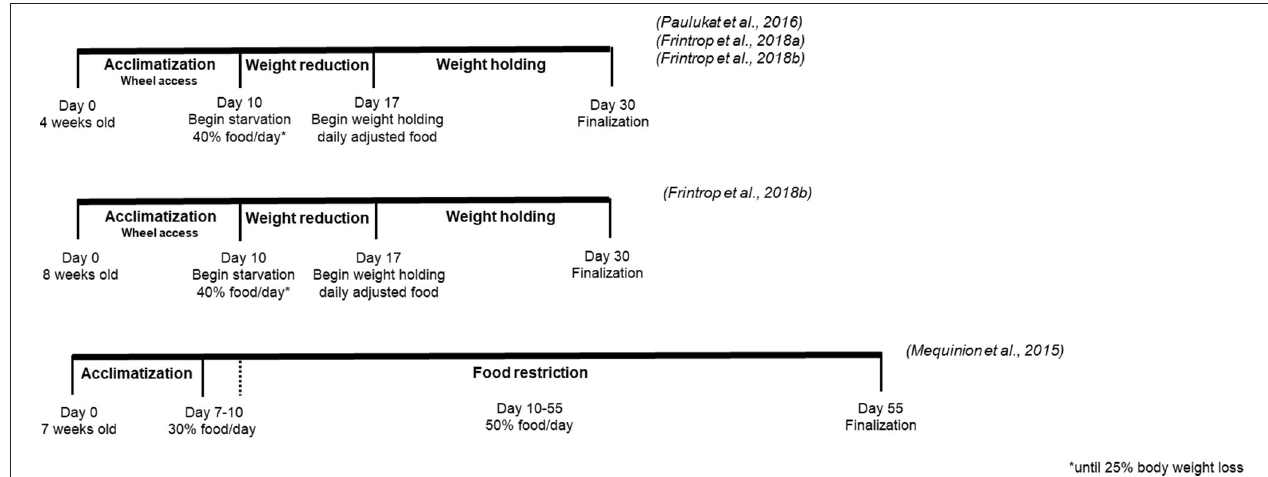
FIGURE 3 | Comparison of different chronic activity-based anorexia